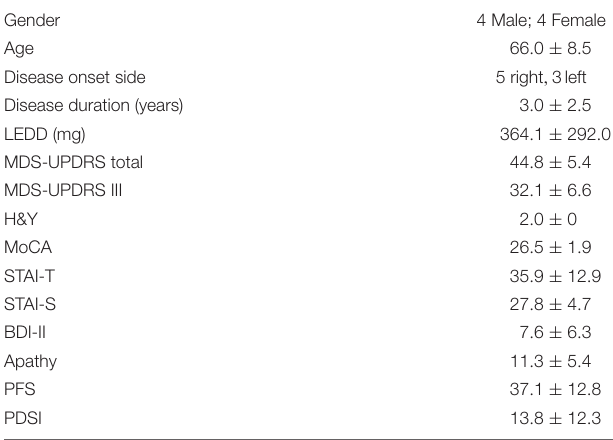
TABLE 1 | Demographic and clinical